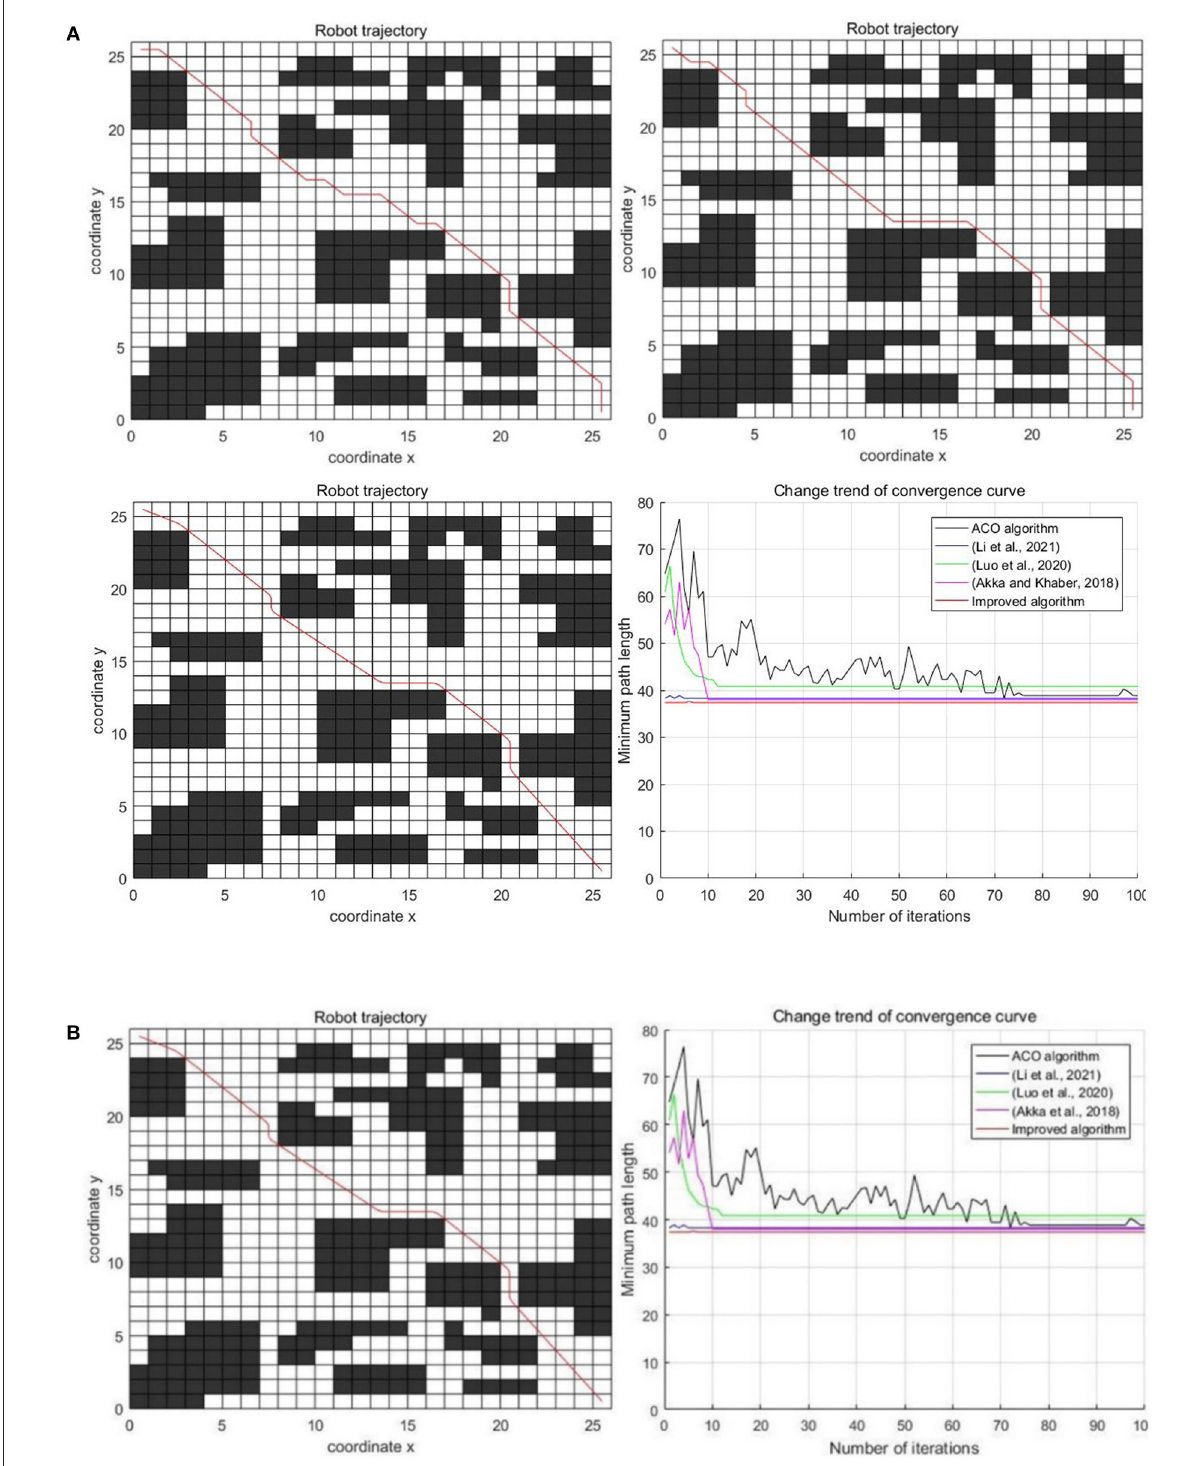
FIGURE10 Experimental results of three algorithms in the concentrated obstacle environment. (A) Classic ant colony algorithm, Luo et al. (2020), Li et al. (2021), and Akka and Khaber (2018) (B) Improved algorithm and comparison of five